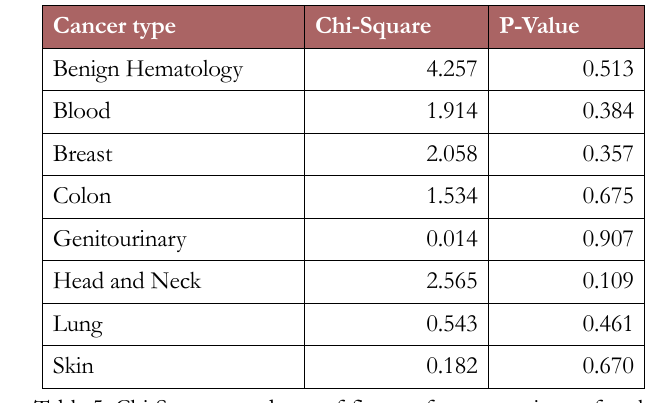
Table 5. Chi-Square goodness-of-fit tests for new patient